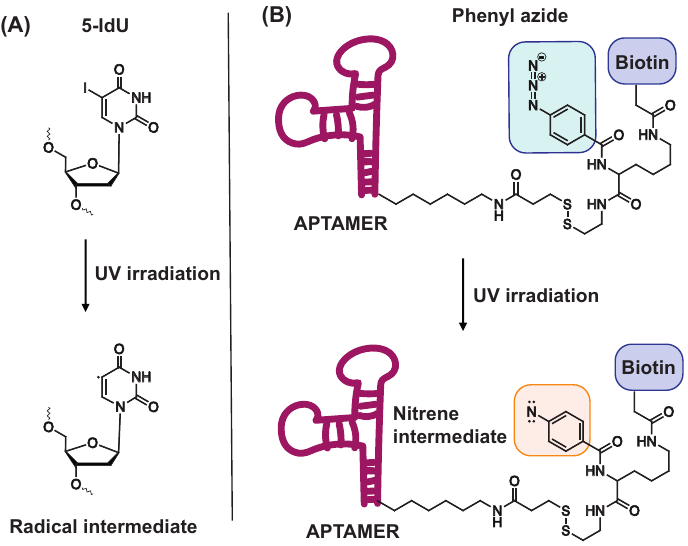
Figure 14. Structure of the crosslink reagents and reactive species formed upon UV irradiation of 5-iodo-2 (cid:48) -deoxyuridine ( A ) and phenyl azide ( B